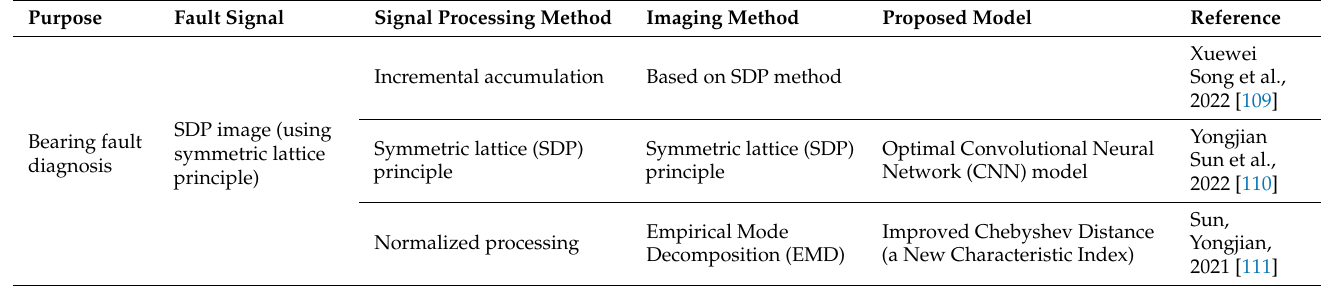
Table 11. Summary and comparison table of SDP image